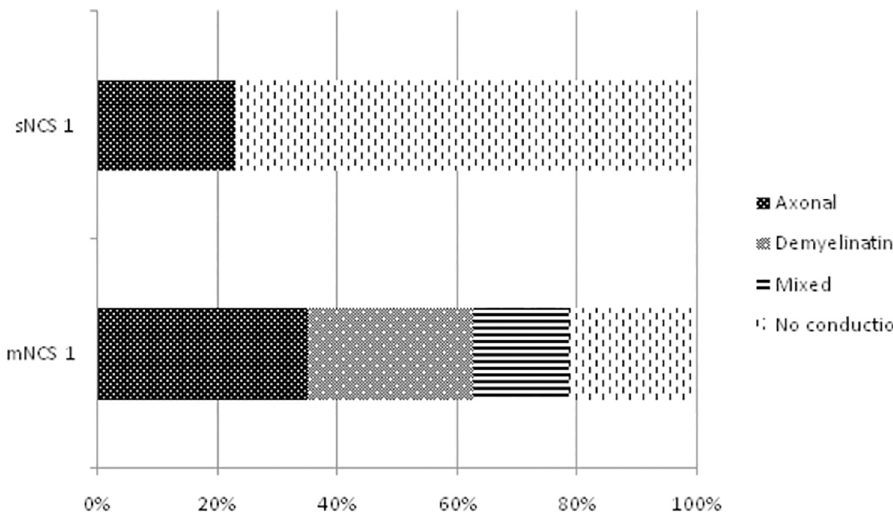
Fig 1. Nerve conduction study (NSC)patterns of the abnormal nerves before the MDT. Mixed: axonal and demyelinating. sNCS: sensory NCS. mNCS: motor NCS.